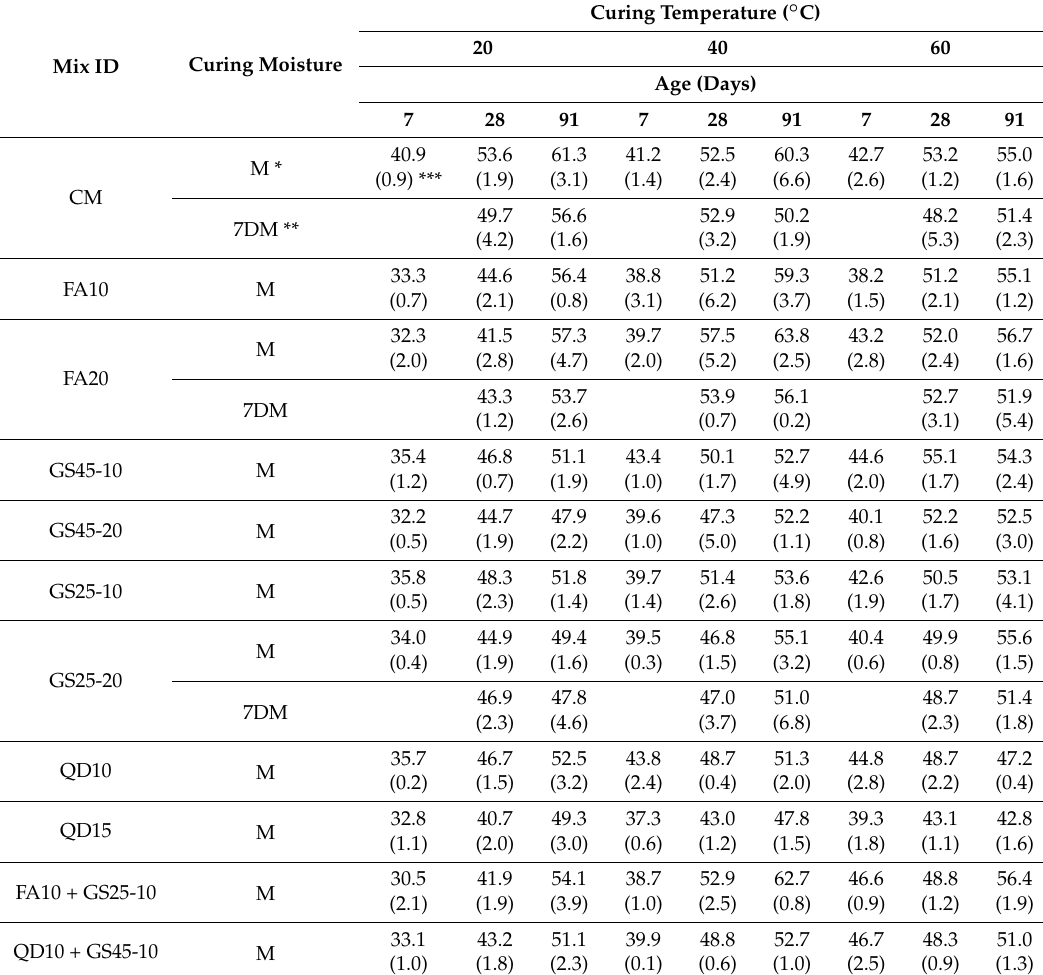
Table 5. Compressive strength (MPa) of mortars with respect to aging, curing temperature and moisture. CM, control